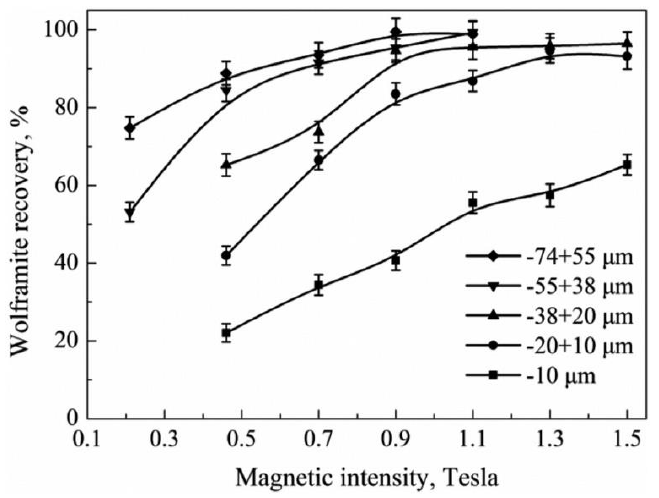
Figure 4. Recovery of different size fractions of wolframite as a function of magnetic intensity [84]. Wet high-intensity magnetic separation (WHIMS) has been used as an effective en- hanced approach to separate minerals of low magnetic susceptibility from tailings [85]. A WHIMS modeling on tungsten tailings predicted good wolframite recovery rates: approxi- mately 80% (90%) for new tailings and 65% (80%) for old tailings at 0.9 T (1.6 T)